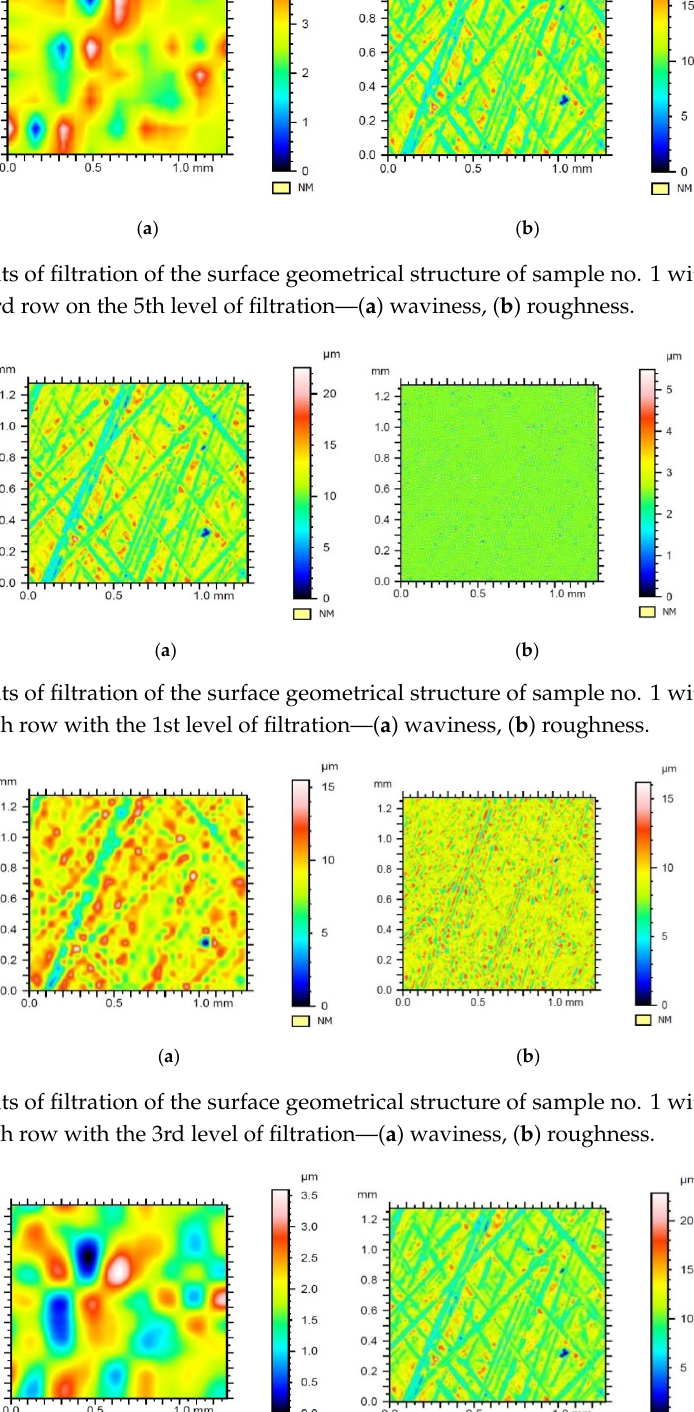
Figure 13. Results of filtration of the surface geometrical structure of sample no. 1 with Daubechies wavelet of the 6th row with the 5th level of filtration—( a ) waviness, ( b ) roughness.